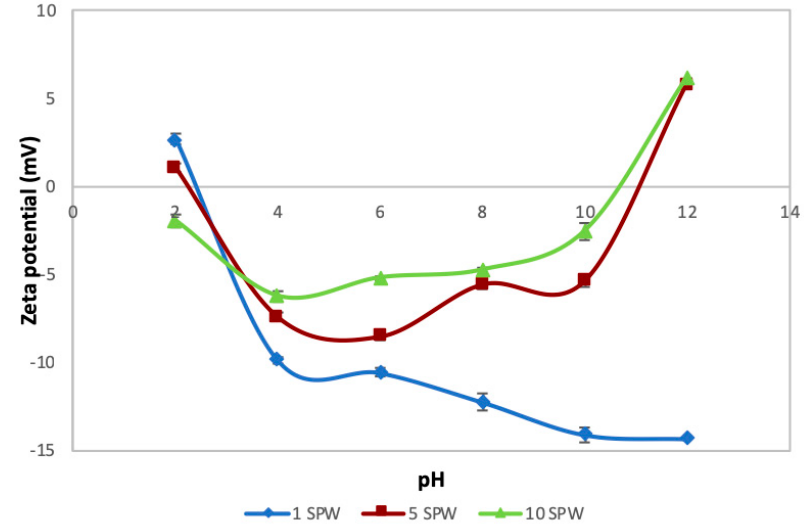
Figure 6. Zeta potential as a function of pH under increasing ionic strength conditions for talc.